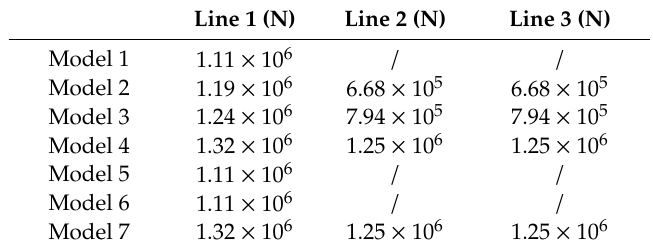
Table 7. Natural period of each model.